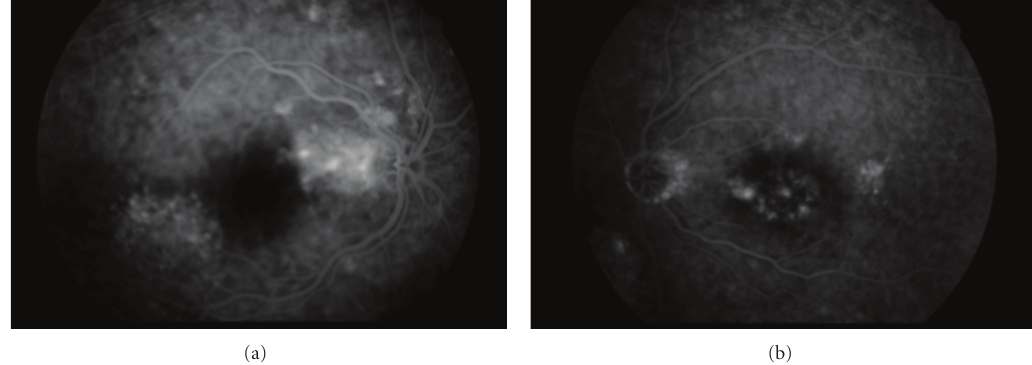
Figure 2: (a) Focal leakages in the macular region of the right eye view of the FFA. (b) Focal leakages in the macular region of the left eye view of the